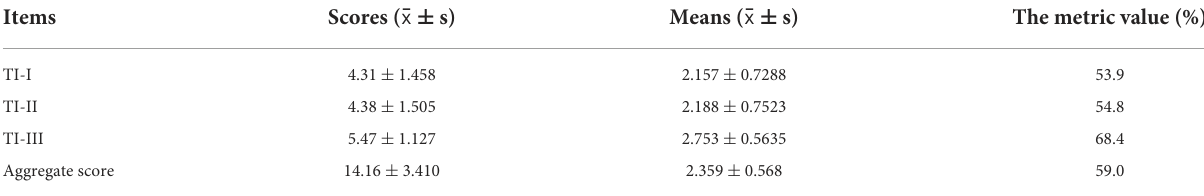
TABLE 4 Scores of each dimension of turnover